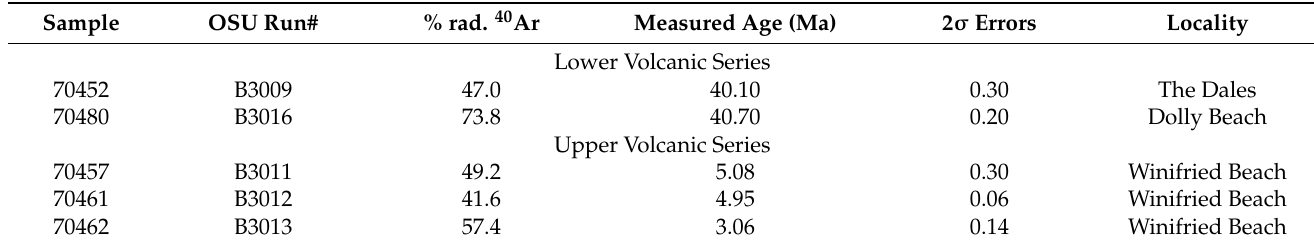
Table 1. 40 Ar –39 Ar Total Fusion Ages for Christmas Island volcanic